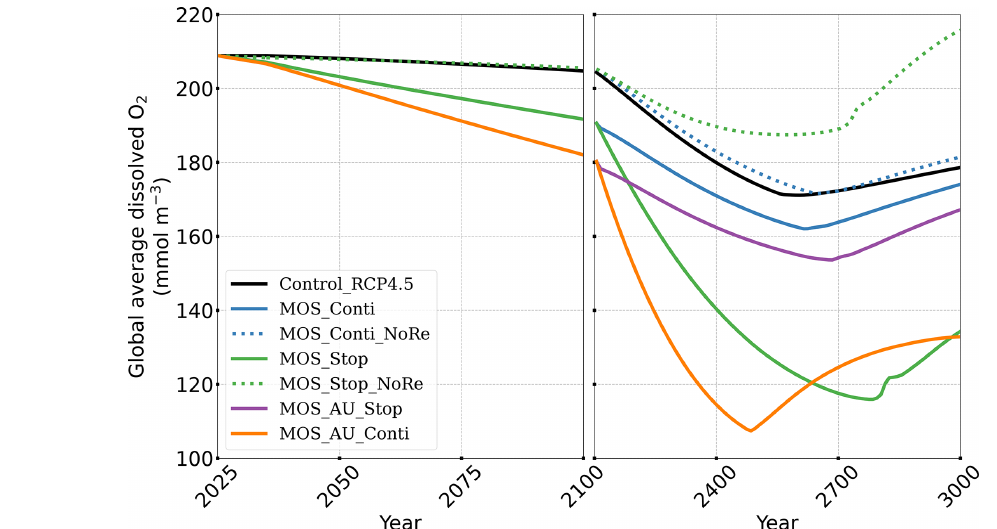
Figure B8. Upper-ocean 3000–6000m averaged dissolved-oxygen concentrations.